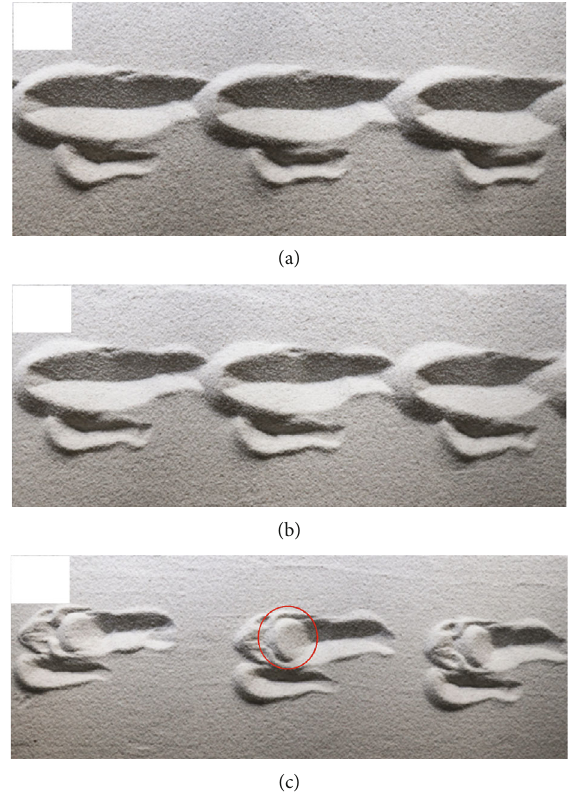
Figure 12: The footprints of the bionic mechanical foot on the loose sand. (a) Footprints at low speed. (b) Footprints at medium speed. (c) Footprints at high